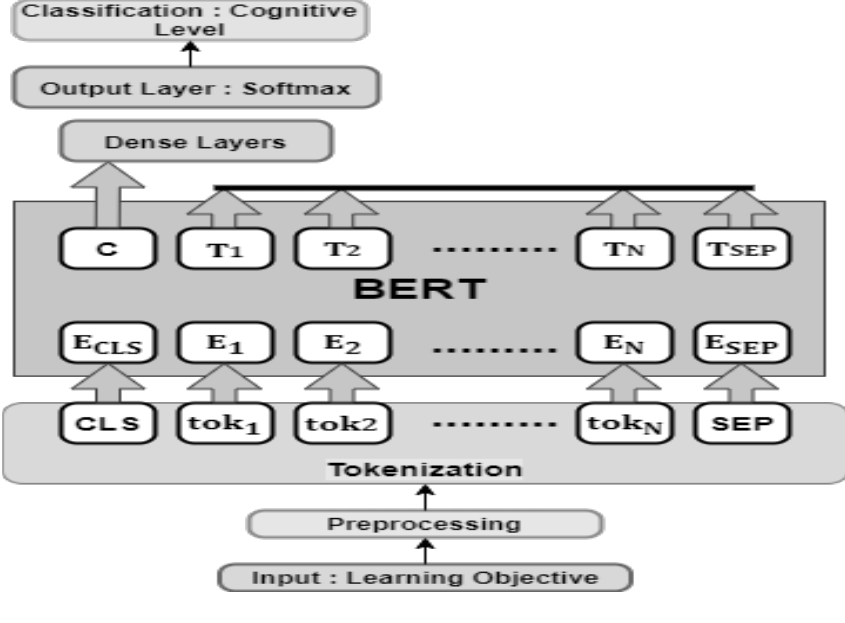
Figure 4 BERT With Fully Connected Layers